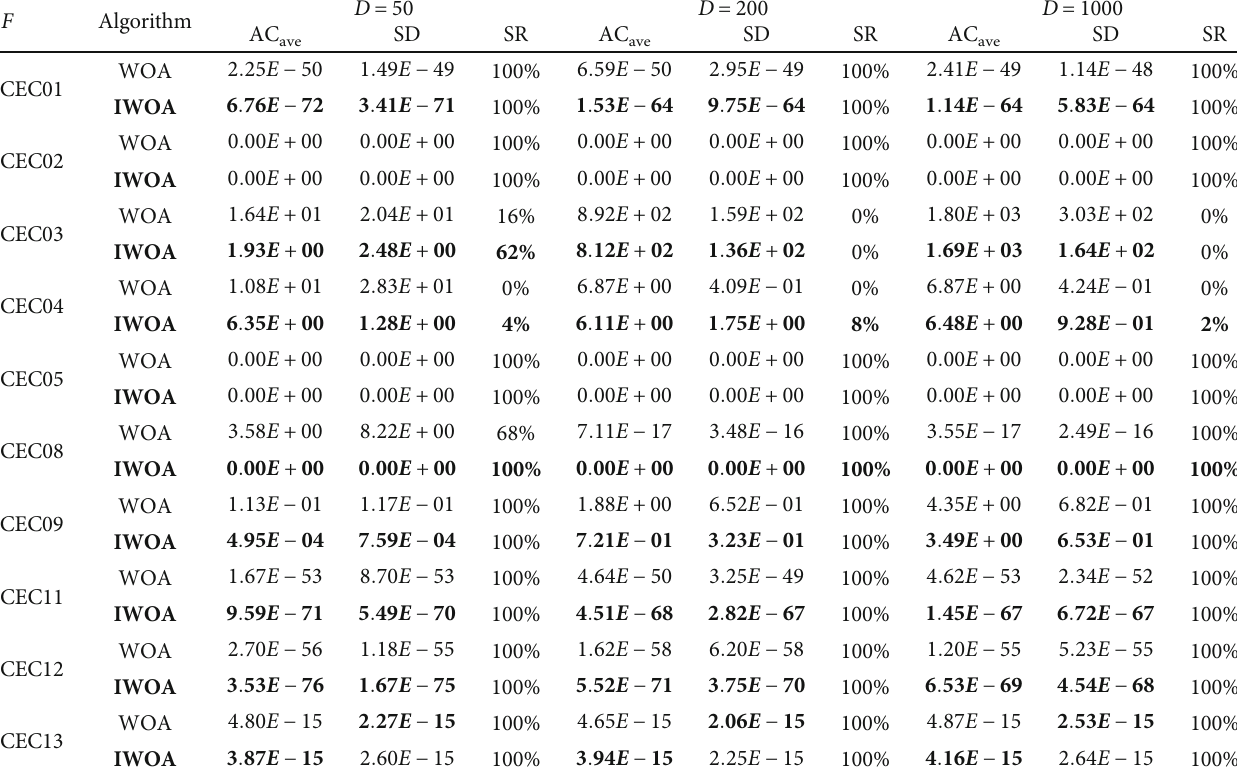
Table 11: Optimization comparison of two algorithms